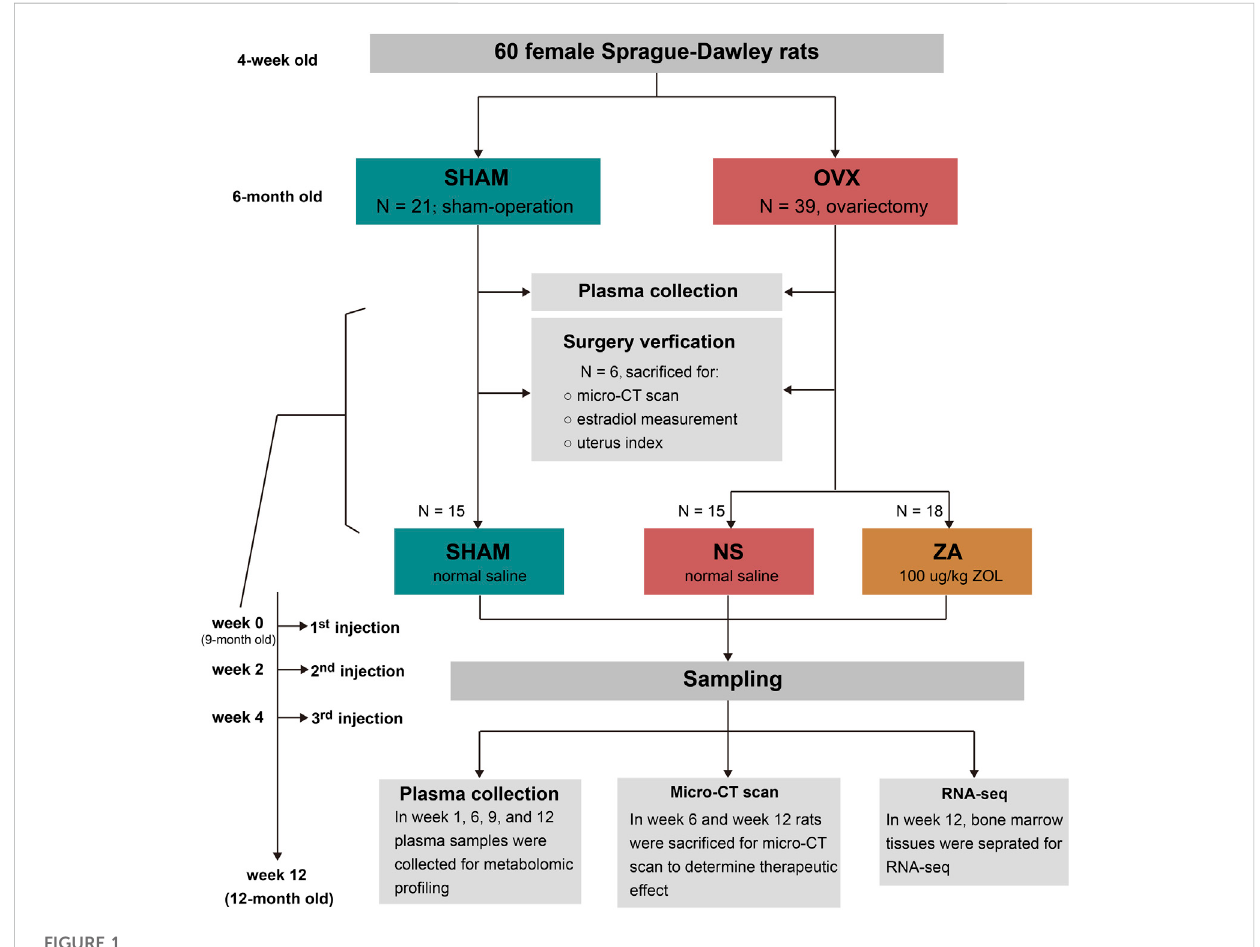
Illustration of the study